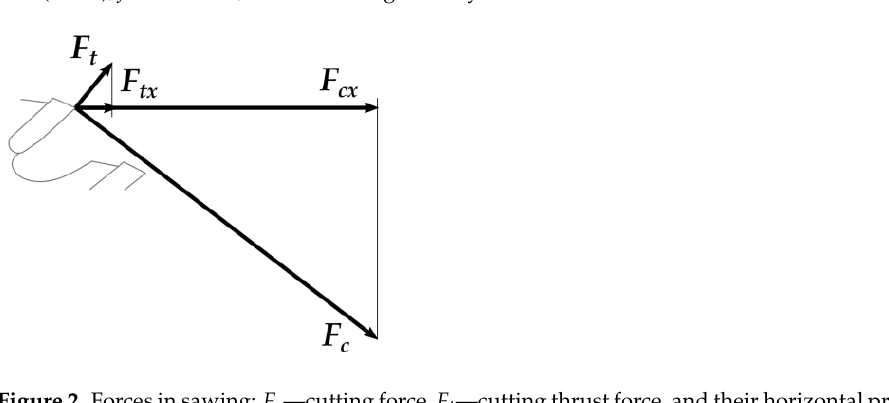
Figure 1. Sawing experiment setup: a —saw projection beyond the workpiece, h —thickness of particleboard, ω 1 —saw enter angle, ω 2 —saw exit angle, n —rotation of saw, c —peripheral velocity of saw (tooth), f —feed rate, v —real cutting velocity.